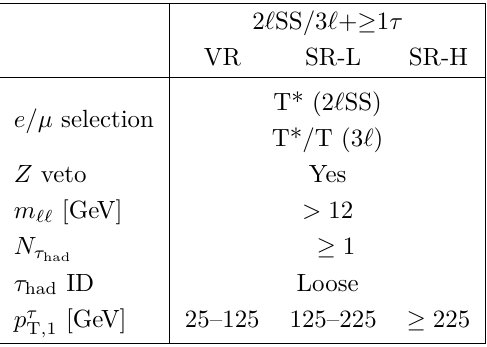
Table 5. Summary of event categories in the 2 ‘ SS/ 3 ‘ + ≥ 1 τ channel. All events are required to satisfy the preselection requirements. “T” and “T*” denote the Tight and Very Tight light-lepton selection criteria (see table